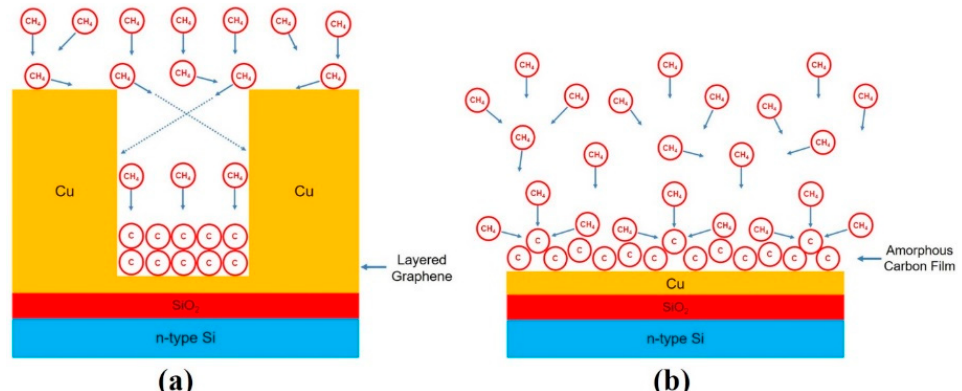
Figure A10. ( a ) Diagram for describing the mechanism about the formation of nanolayered carbon film in a nanoscale Cu hole, where the hole functions as a filter and select only the species moving in the direction parallel to the hole wall to enter the hole and reach the bottom; ( b ) diagram for describing the mechanism about the formation of the amorphous carbon film on a flat smooth Cu surface due to the random moving direction of species.